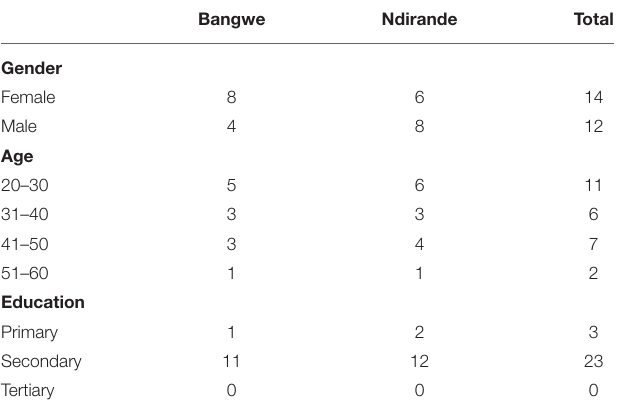
TABLE 1 | Sociodemographic details of workshop